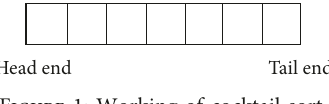
Figure 1: Working of cocktail